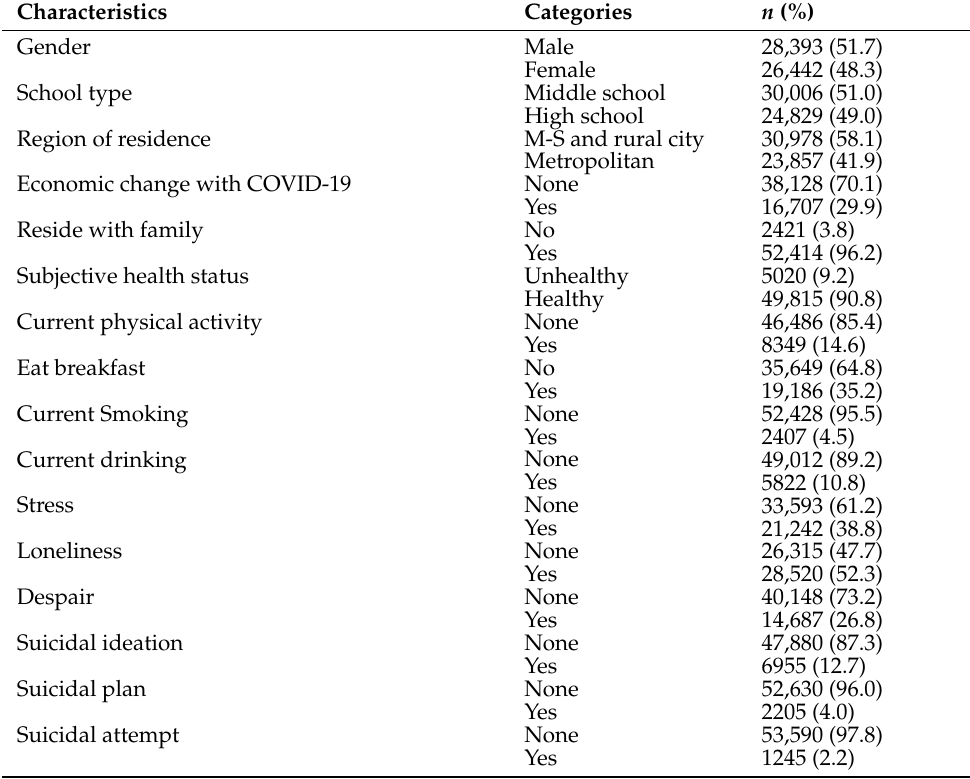
Table 1. Participants’ characteristics ( n = 54,835).